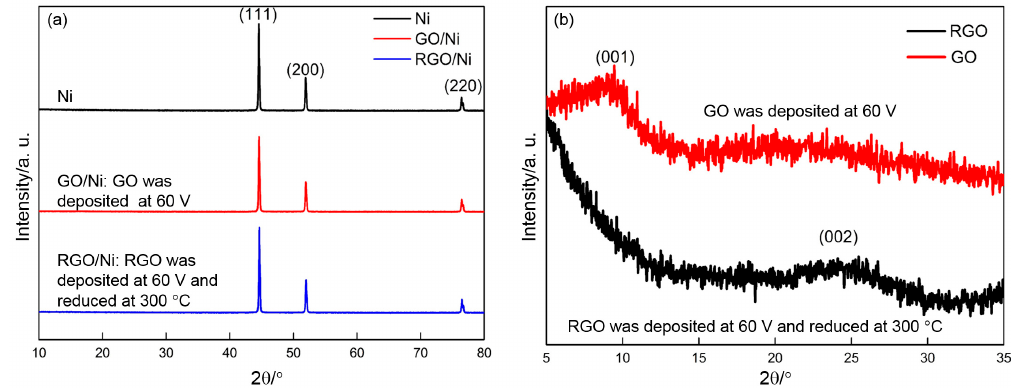
Figure 8. ( a ) XRD patterns of Ni, GO/Ni, and RGO/Ni; and ( b ) XRD patterns of GO and RGO.